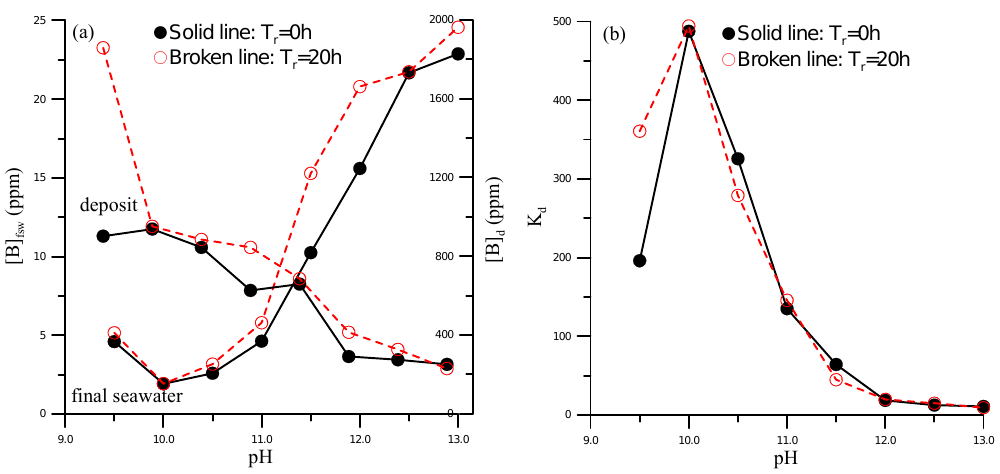
Fig. 2. Boron concentrations (a) and partition coefficient K d (b) between brucite deposit and final seawater for T r =0 h and 20 h. The variation trend of the results for T r = 0 h and T r = 20 h are basically the same (Fig. 2a) , indicating the incorporation of boron into brucite deposit is instantaneous. [B] fsw decreases firstly and then increases quickly with the lowest value at pH 10 (Fig. 2a), indicating the amount of boron incorporated into deposited brucite increases firstly and decrease as pH increases, and reaches the highest value at pH 10. The variation trend of K d is contrary to that of [B] fsw (Fig. 2b).